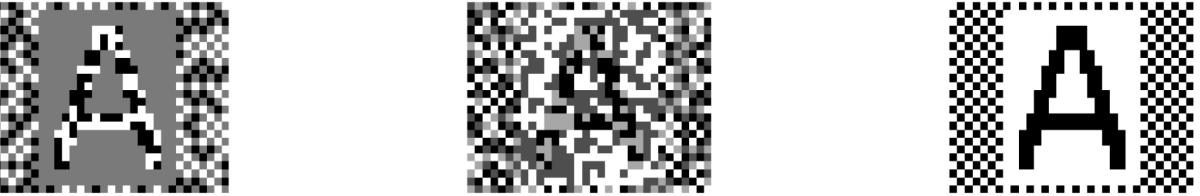
Figure 7. Scrambling effects. Right: the target afterimage pattern. Left: a corresponding bias image using the mapping scheme ({1}, {2}, {1}). Middle: a stronger result using mapping scheme ({1}, {2}, {1}, {2}).